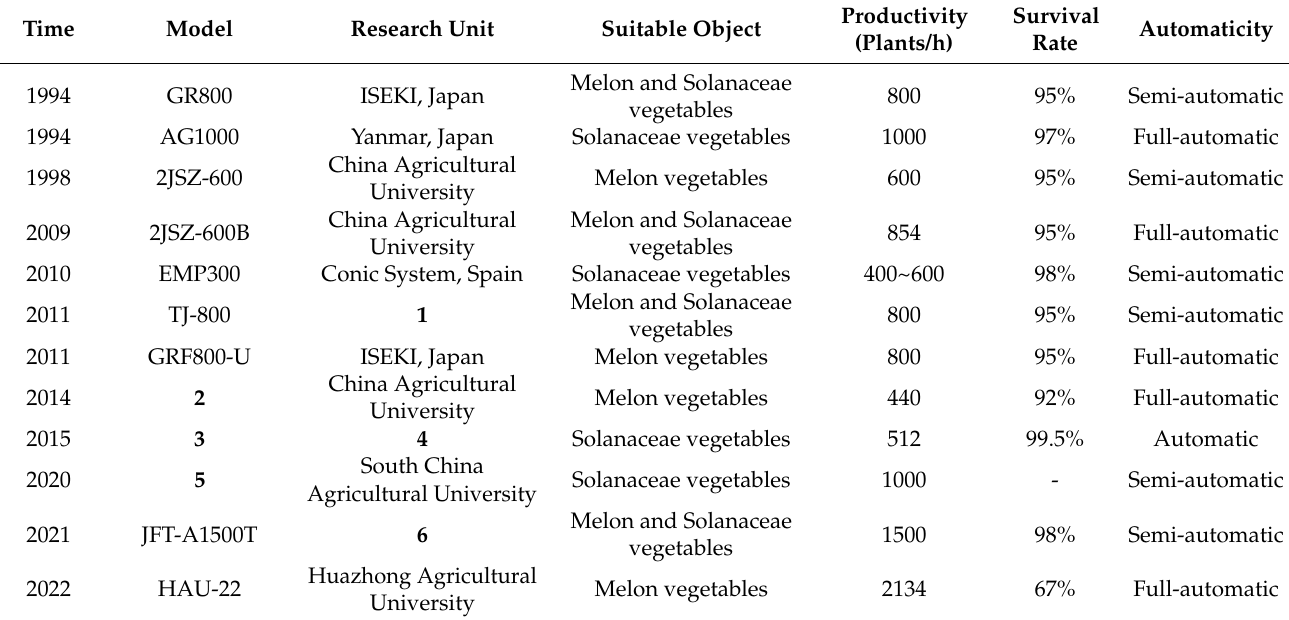
Table 1. Comparison of the characteristics of the vegetable grafting robots based on splice grafting.